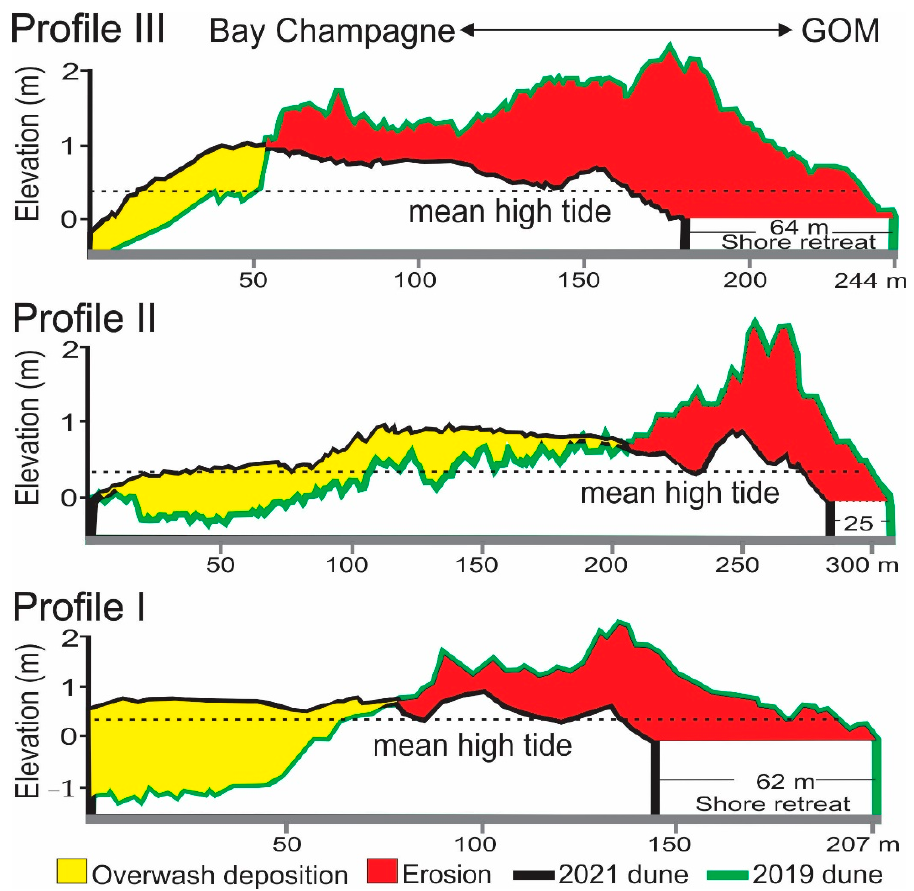
Figure 5. Planialtimetric cross-shore profiles I, II, and III (see location in Figure 1d) based on drone data. The dune crest positions along the three profiles were marked by green line in Novem- ber/2019 and by black line in November/2021. The red and yellow areas mark the erosion and re- deposition of the beach barrier sediments.